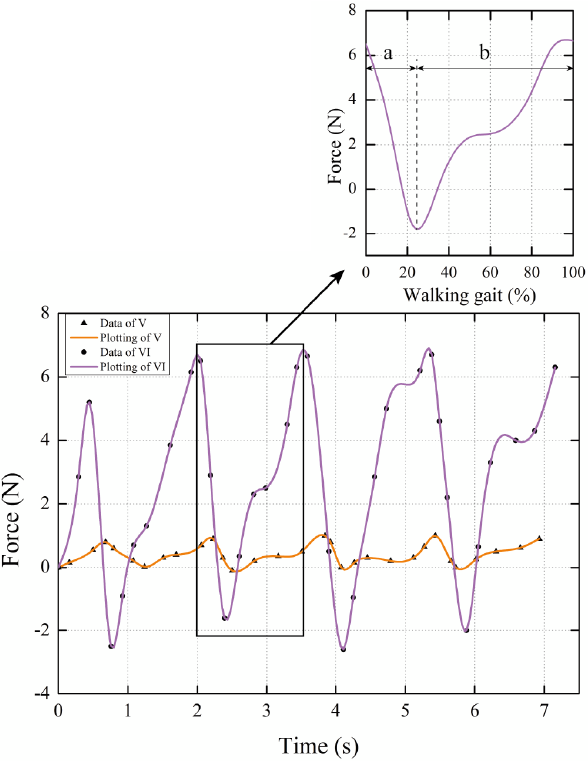
Figure 12. Performances comparison in walking process.